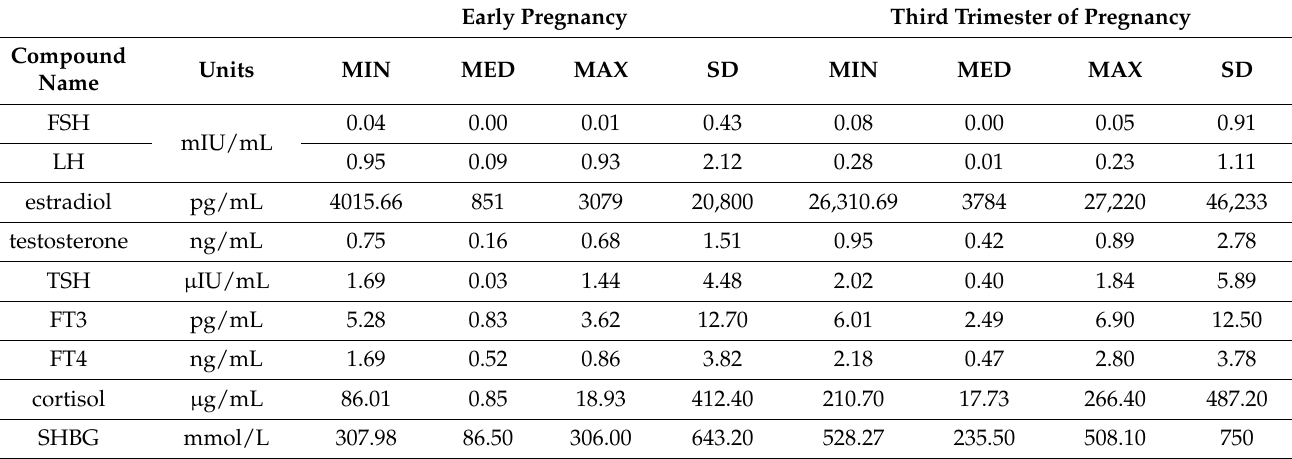
Table 6. Descriptive statistics of serum hormone